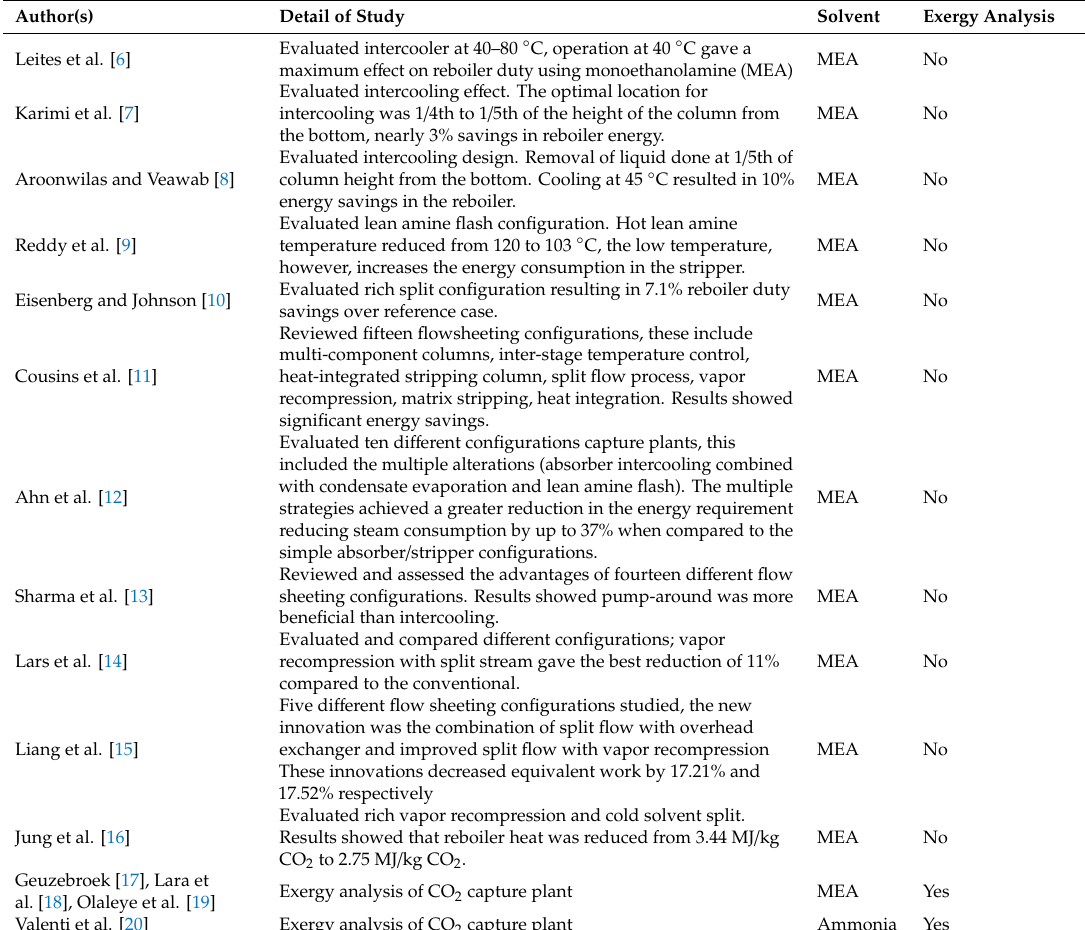
Table 1. Summary of representative past works on flowsheeting configurations for CO 2 capture plants.